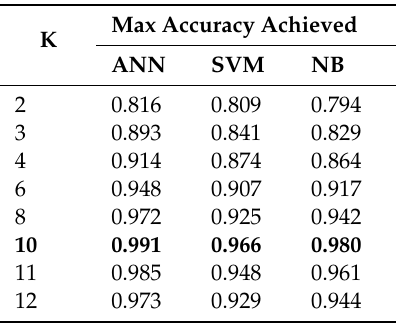
Figure 9. Block diagram of a hybrid classifier training and classification. Table 5. Classifiers K-Fold cross validation